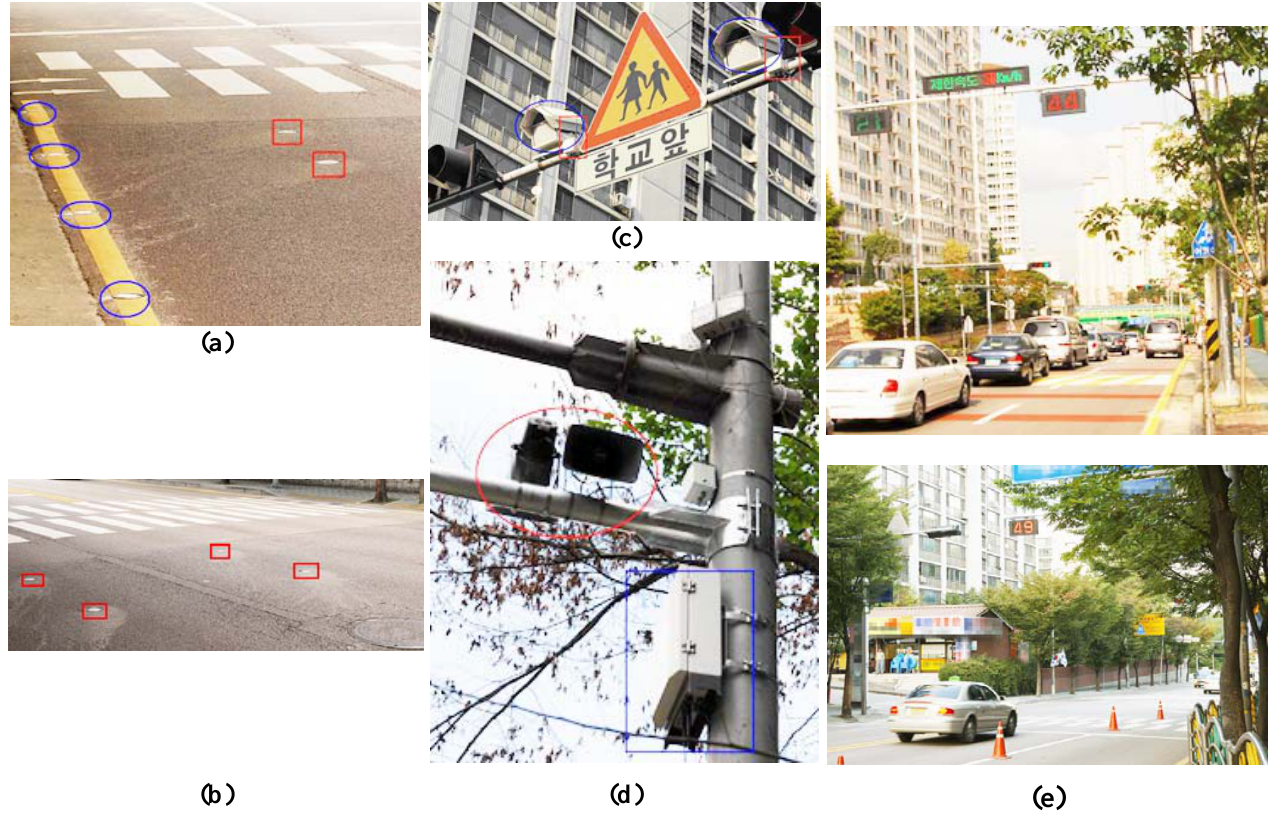
Figure 11. S3 in real school zones. (a) 4 T-Sensor-p nodes and 2 T-Senor-v nodes. (b) 4 T- Sensor-v nodes in two lanes. (c) Speed camera (blue circle) and T-Act-s (red rectangle). (d) T-BS (blue rectangle) and loud speakers (red circle). (e) VMS is notifying that the speed limit is 30 km/h and the current measured speed is 21 km/h (in green), 44 km/h and 49 km/h (in